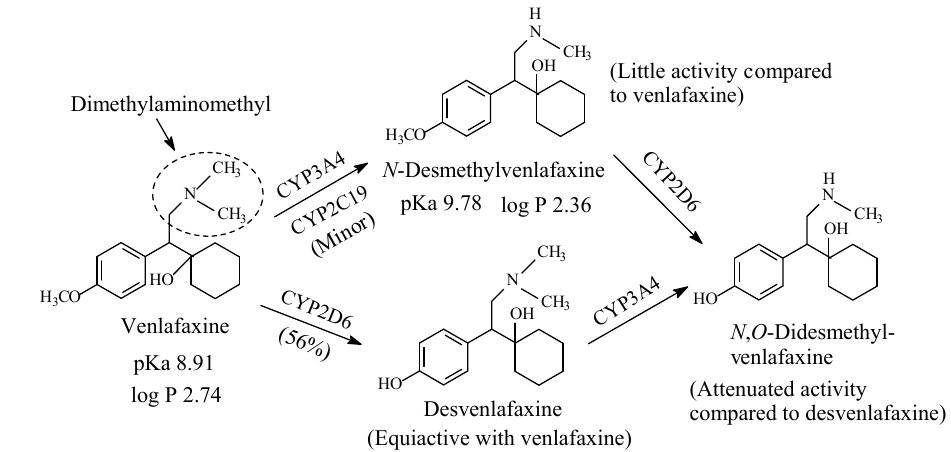
Figure 6. Major metabolic pathways of venlafaxine.